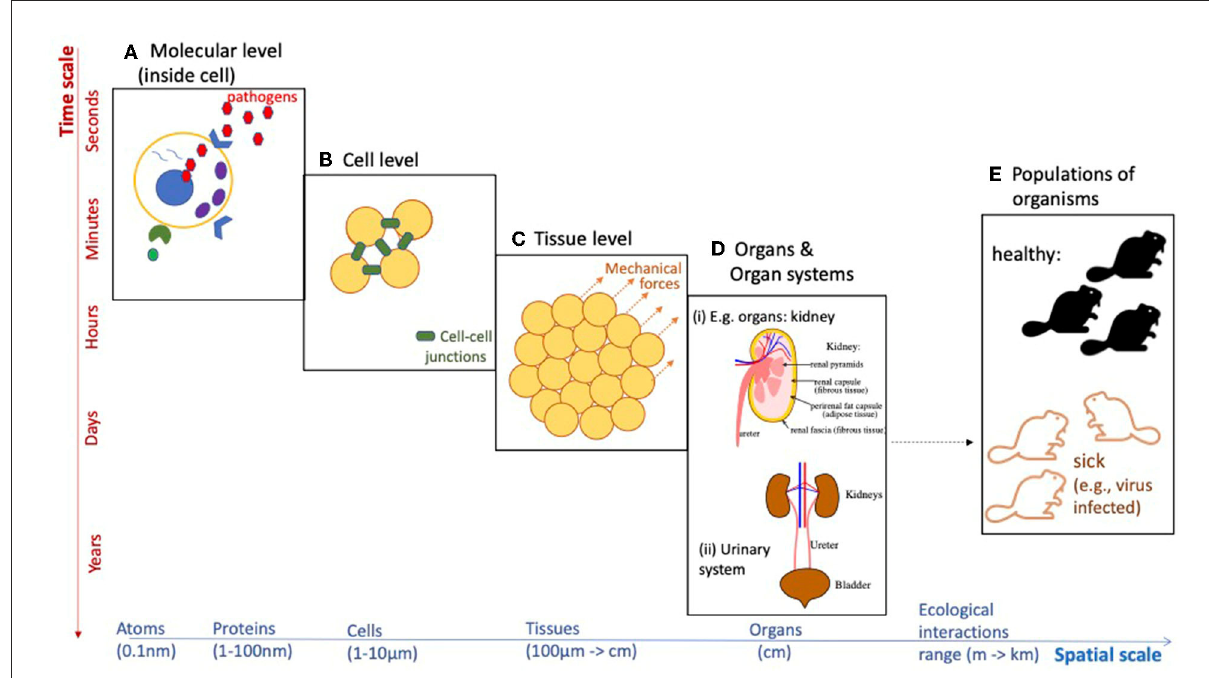
FIGURE1 Diagram emphasizing the multi-scale aspects of various biological phenomena. Such biological processes can take place across different spatial and/or temporal scales. (A) Molecular level (inside cell), (B) cell level, (C) tissue level, (D) organs and organ systems, and (E) populations of